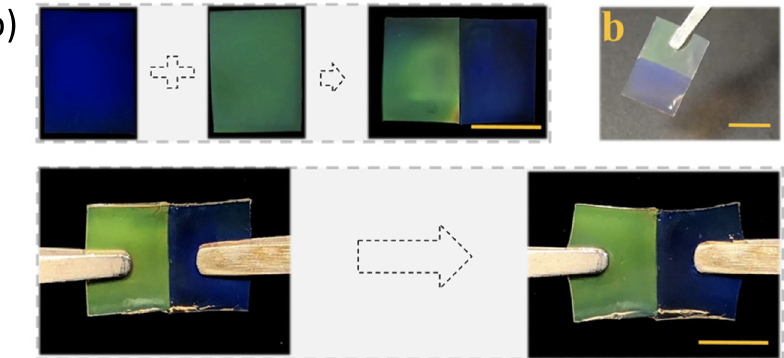
Figure 8. ( a ) The preparation of a magnetic anisotropic self-healing hydrogel composed of N-carboxyethyl chitosan and aldehyde hyaluronic acid crosslinked by dynamic imine covalent bonds. Adapted with permission from [76]. Copyright 2018, American Chemical Society. ( b ) The welding of two self-healing hydrogels with different structural colours. Adapted with permission from [77] .